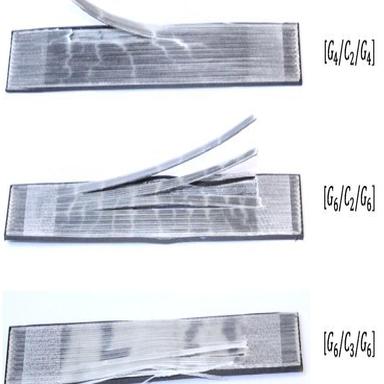
Image of failed samples for the hybrid laminate configurations, (Images were taken after the final failure). (For interpretation of the references to colour in this figure legend, the reader is referred to the web version of this article.)